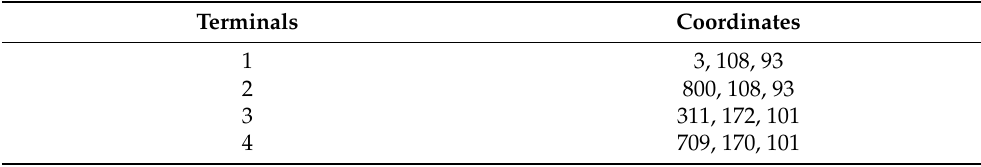
Table 3. Coordinates of the terminals of the 2nd pipe.